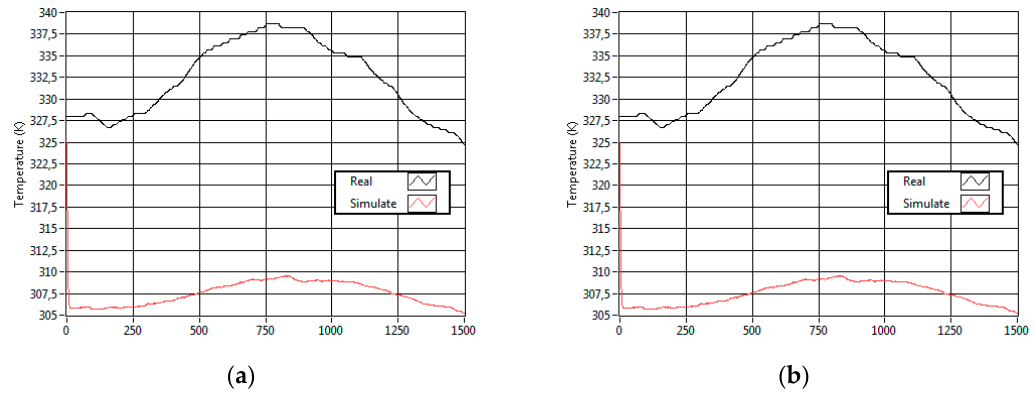
Figure 4. Model test using the initial parameters: ( a ) stack temperature; ( b ) output voltage.